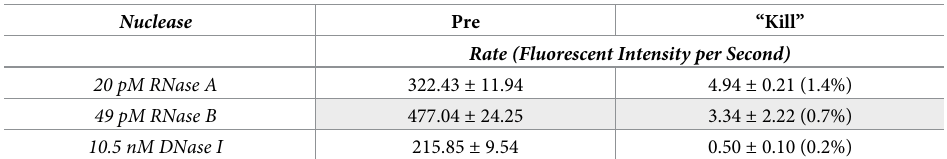
Table 3. Nuclease inactivation